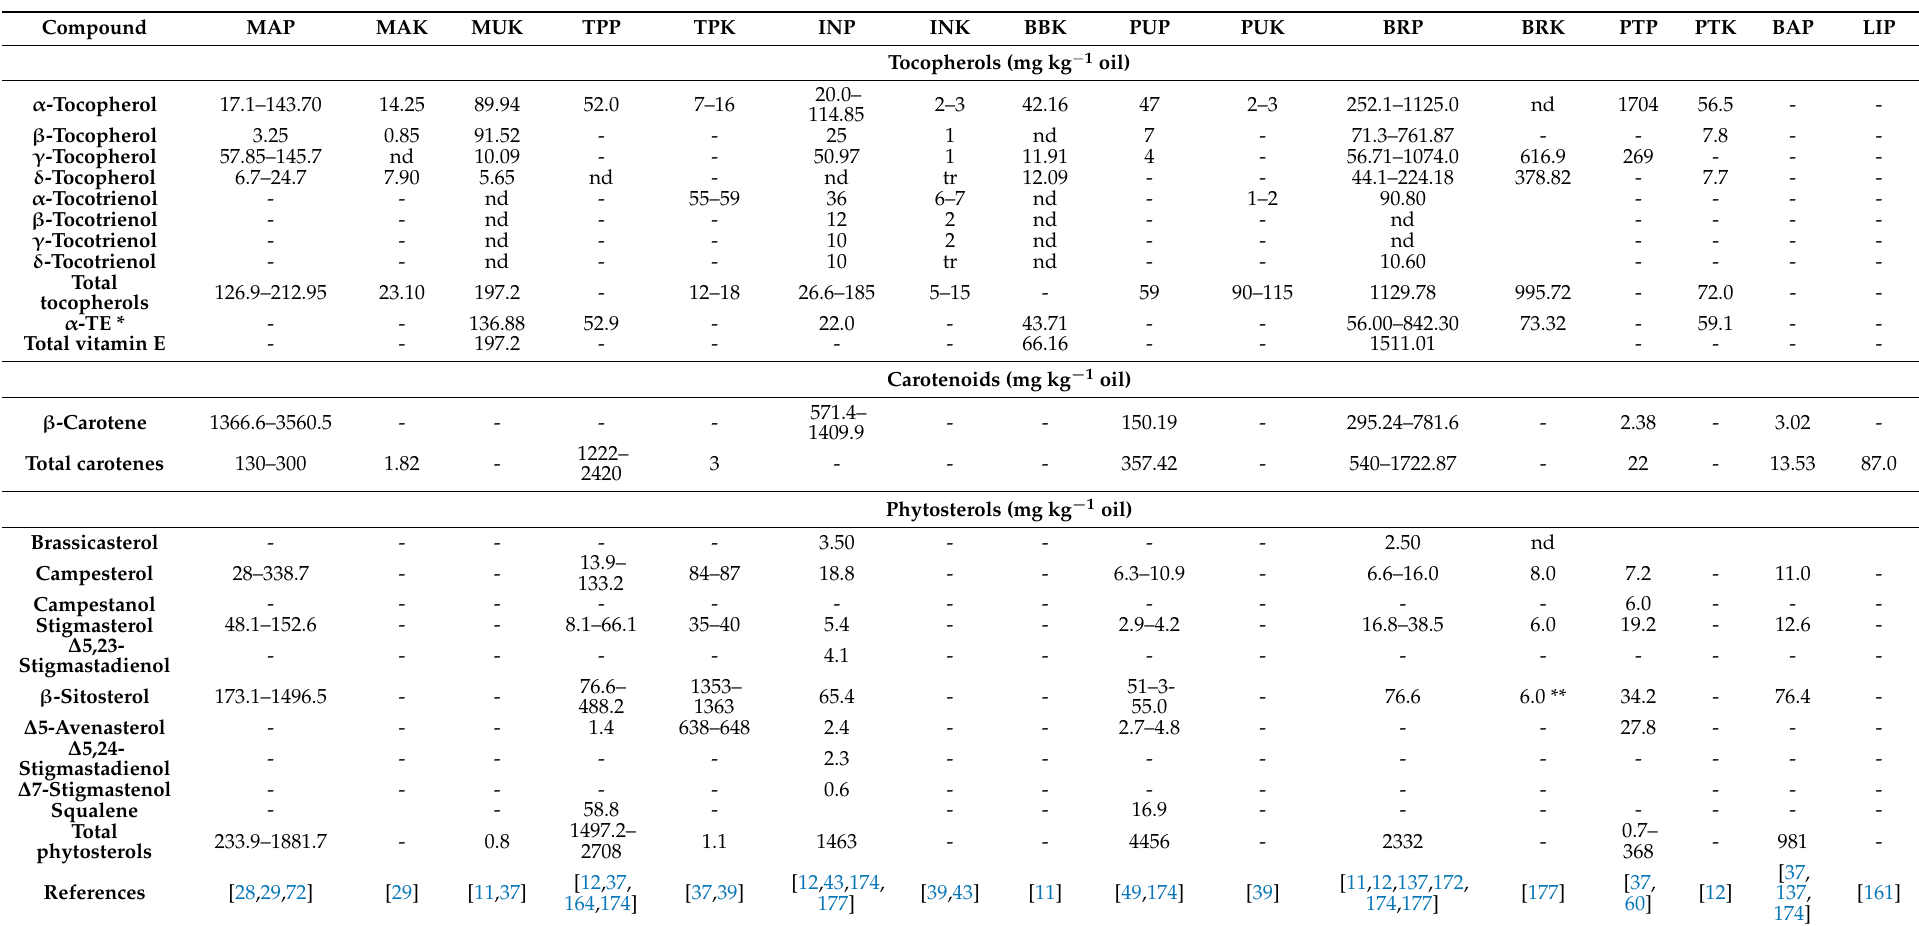
Table 5. Bioactive lipids of Arecaceae palm fruit